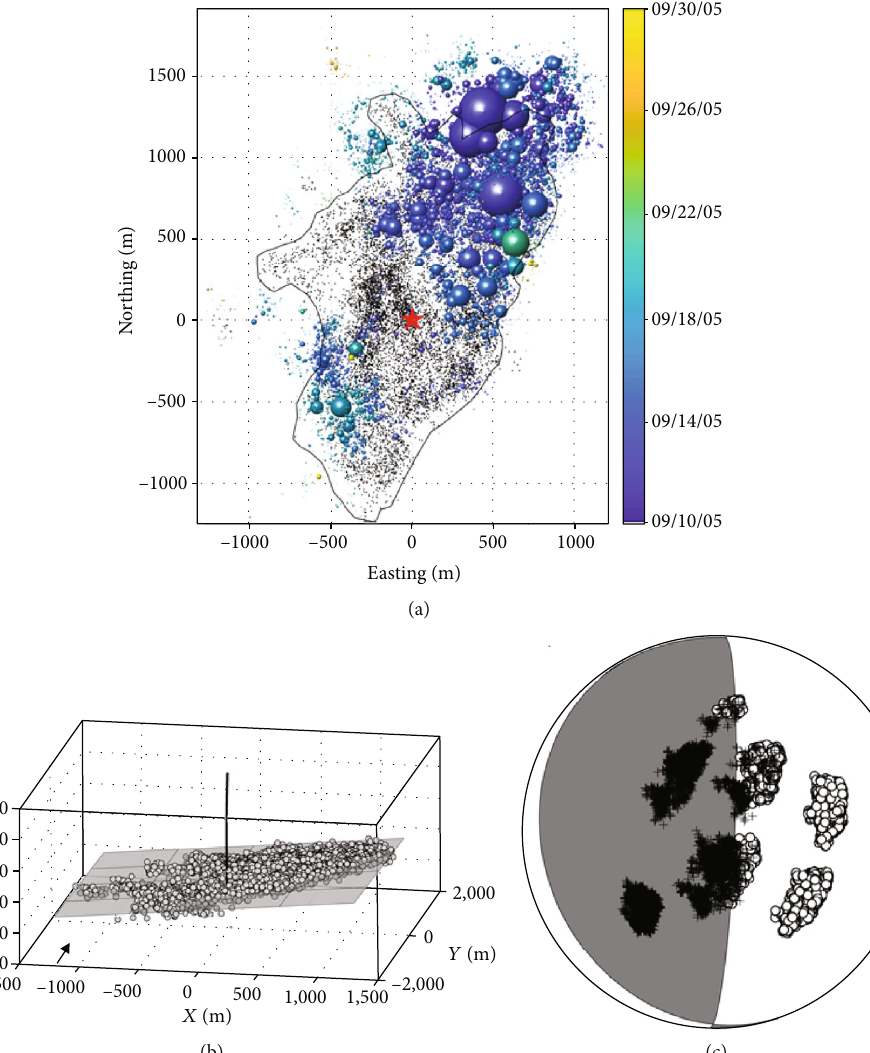
Figure 7: (a) Hypocentre locations of the seismicity induced during the 2005 restimulation of well Habanero#1 (red star) in map view [15]. Each seismic event is displayed by a globe scaled to the event magnitude. Colour encoding denotes occurrence time according to the legend. Seismic activity associated with the initial stimulation of well Habanero#1 in 2003 [19] is indicated by grey dots. Contour line indicates 2003 seismicity. (b) Absolute hypocentre locations in perspective view with best- fi tting plane determined by linear regression. (c) Earthquake source-centred, stereographic projection (lower hemisphere) of P -wave polarity data of the dominating type 1 events, see [15]. Beachball indicates compound fault plane solution. Coordinates are given with respect to the top of Habanero#1 (27.81639 ° S/140.75972 °